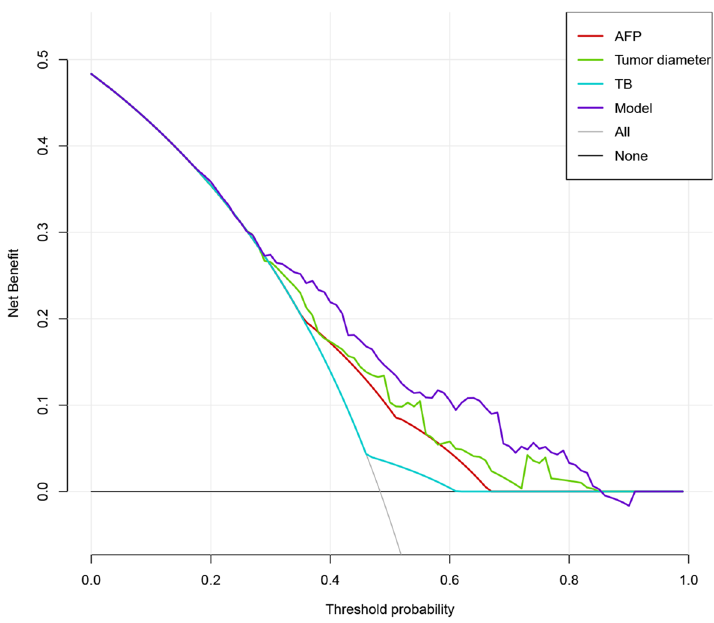
Figure 4. The decision curve analysis for developed nomogram model. The DCA demonstrated that if the threshold probability was > 5%, using the nomogram to diagnose MVI could acquired much more benefit. And the net benefit of the nomogram model was higher than single varirable within 0.3–0.8 of threshold